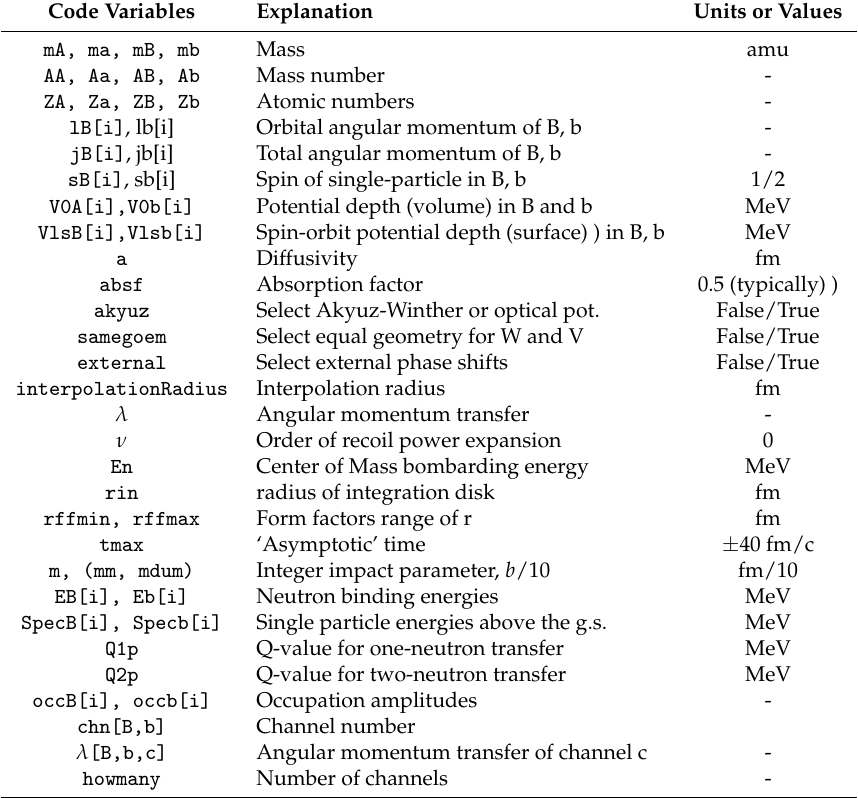
Table 1. Summary of user-defined variables. If the index i is present, it refers to the particular state from 1 to nstB or nstb . Target and projectile are referred to with B and b , while c labels the